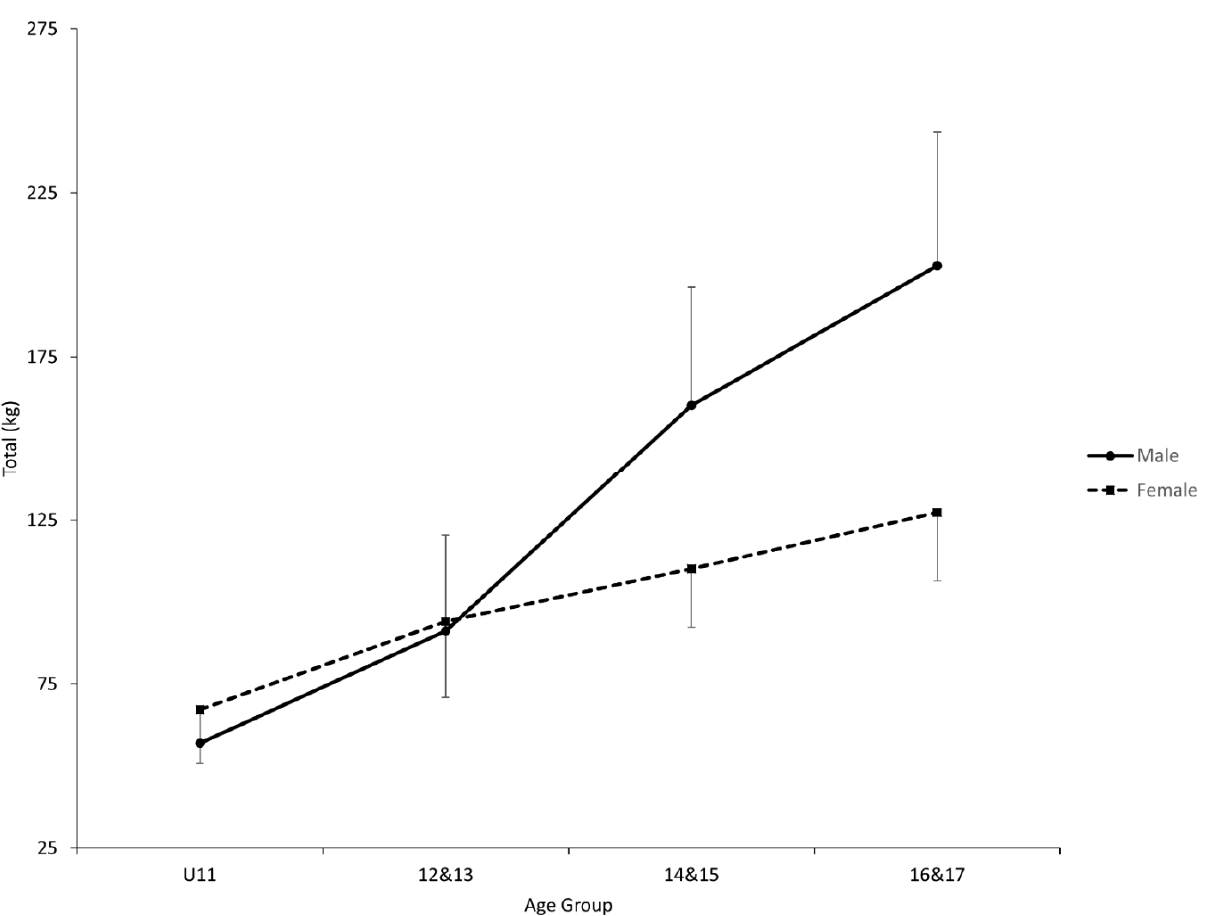
Figure 1. Comparisons of total between age groups and sexes. U11 = 11 and under. 12–13 = age group of 12 and 13-year-olds. 14–15 = age group of 14 and 15-year-olds. 16–17 = age group of 16 and 17-year-olds. The error bars indicate standard deviations. A statistically significant interaction effect was found for sex by age group overall. A statistically significant